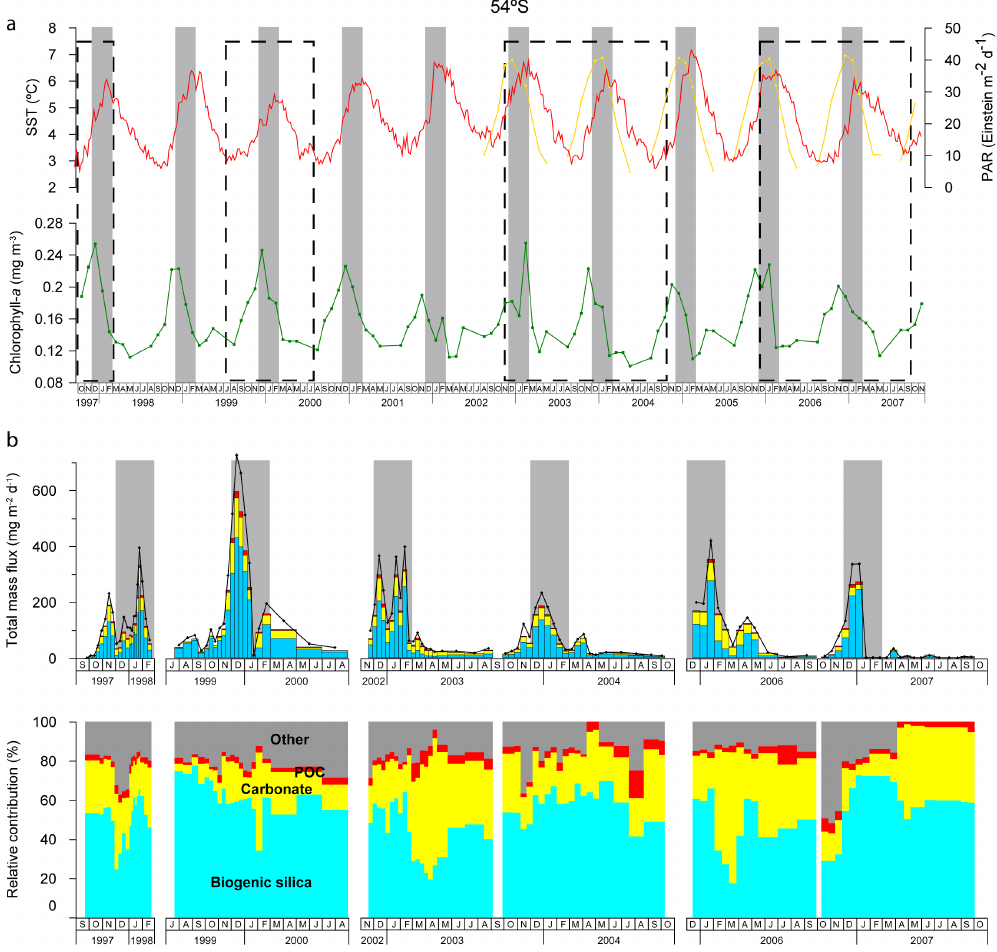
Figure 3. (a) Available mean sea surface temperature (SST), photosynthetically available radiation (PAR) and chlorophyll a concentration for the 54 ◦ S site. The dashed intervals represent the studied periods. (b) Temporal variability of the total and major component fluxes, and their relative contributions to the total mass flux for the <1mm fraction at 800m water depth at the 54 ◦ S site for the periods July 1999–August 2000, November 2002–October 2004 and December 2005–October 2007. Biogenic silica, carbonate and particulate organic carbon (POC) were directly measured. “Other” indicates un-characterised mass contributions (organic components other than carbon and small amounts of lithogenic material; Trull et al., 2001). Grey horizontal bars highlight the summer period (December to February) of each year. Table 1. Deployment summary of sediment traps at stations 47, 54 and 61 ◦ S. Site and trap Hydrographic Latitude Longitude Water column Trap depth designations zone ◦